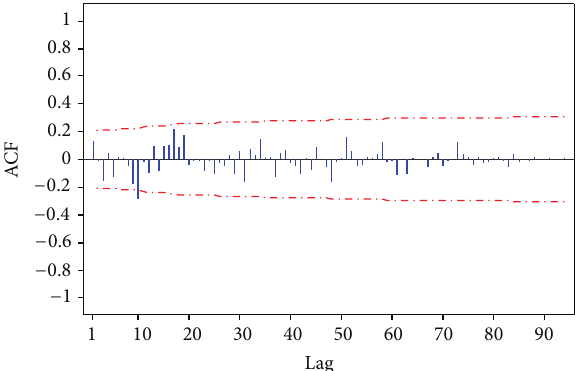
Figure 2: ACF figure in forecasting the load demand on June 23 by seasonal ARIMA